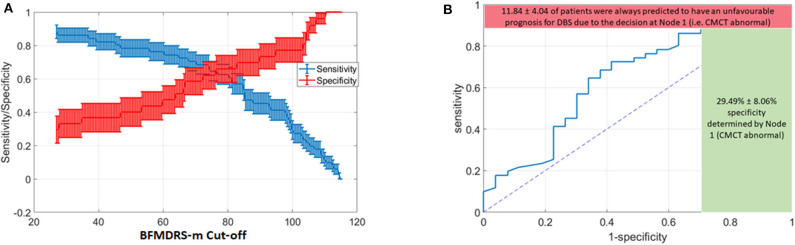
Variation in Decision tree performance with different cut-offs for baseline severity and ROC curve for baseline severity cut-off at point of transection of specificity and sensitivity curves (A) Sensitivity and Specificity for different thresholds on BFMDRS-m at Node 2, after applying the decision tree based on CMCT and BFMDRS-m on patients using Monte Carlo simulation. (B) Corresponding ROC curve which also shows the upper bound on sensitivity (88.16%), and lower bound on specificity (29.49%) determined by the decision at Node 1 (i.e., CMCT abnormal).